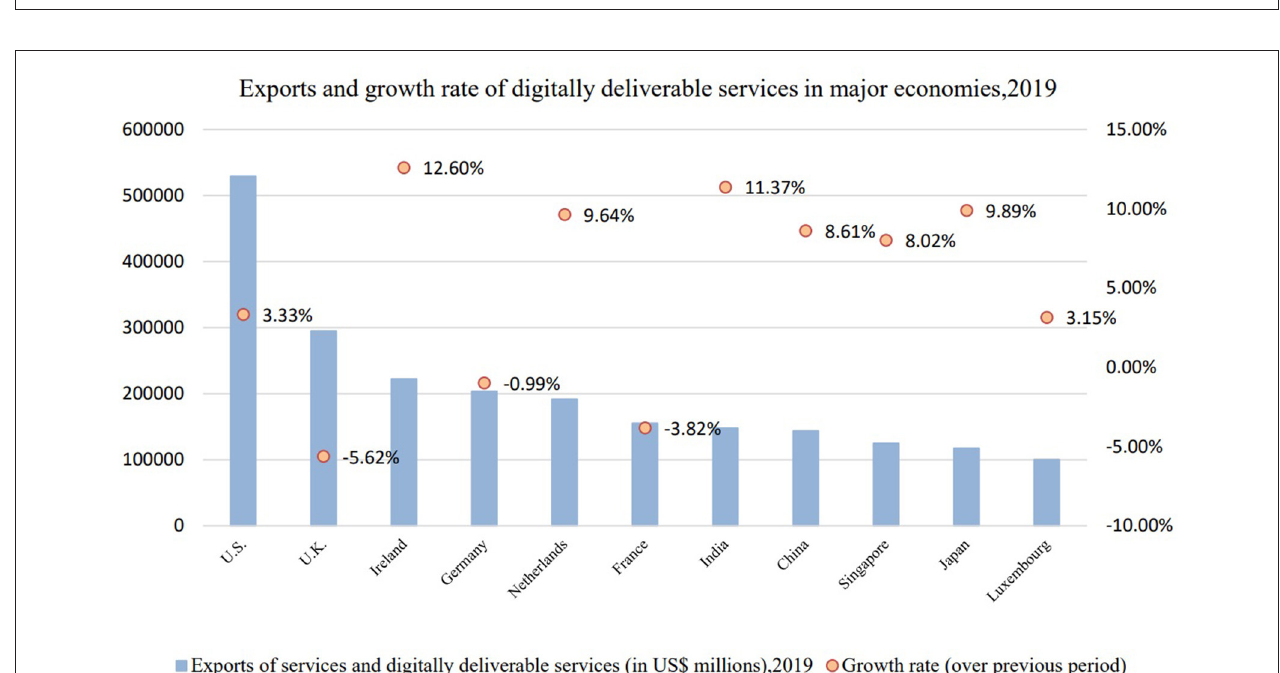
FIGURE 3 | Exports and growth rate of digitally deliverable services in major economies,